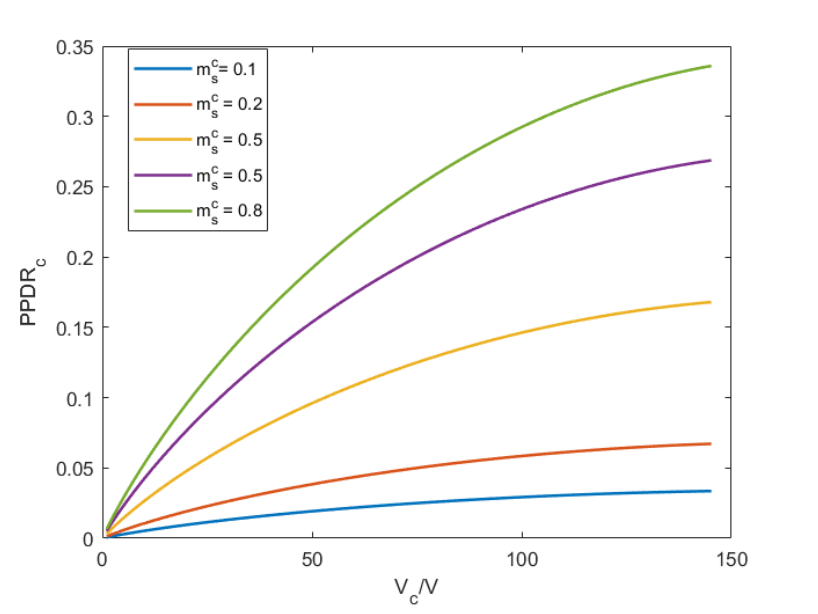
Figure 6. Influence of V c and m c s on PPDR c